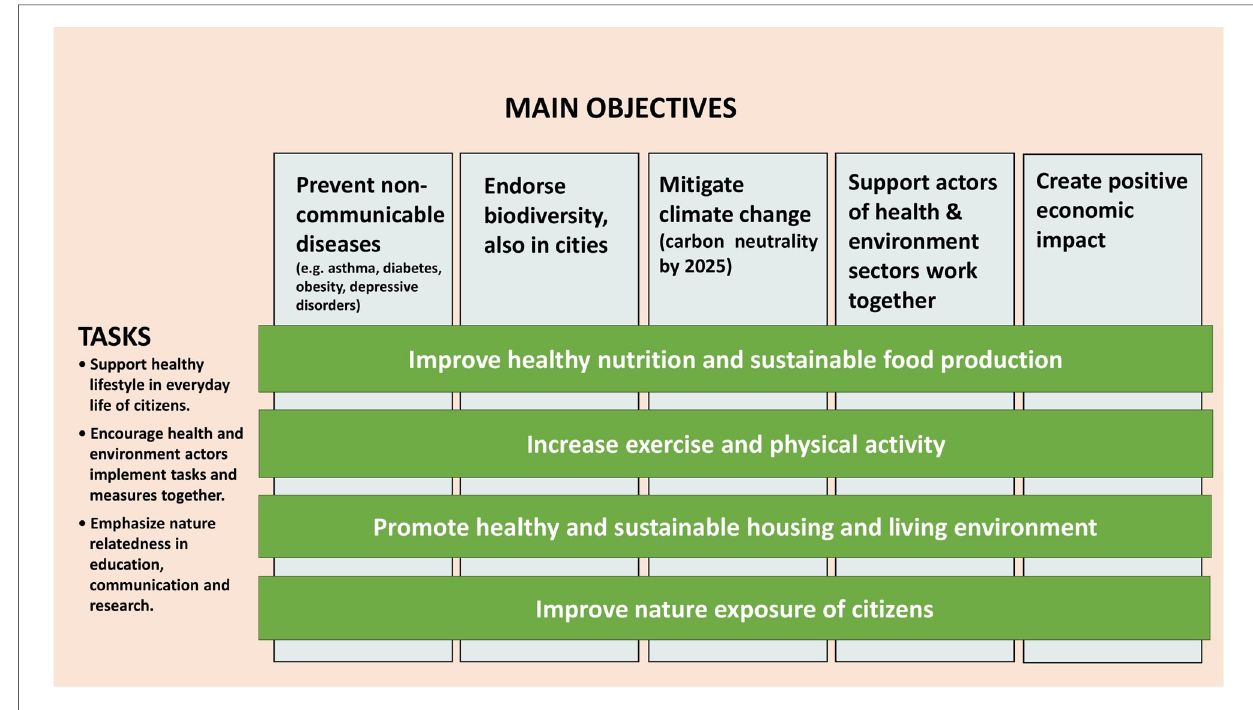
FIGURE 4 Nature step to health — Lahti regional health and environment programme 2022 – 2032. The action plan combines disease prevention and actions for environmental sustainability